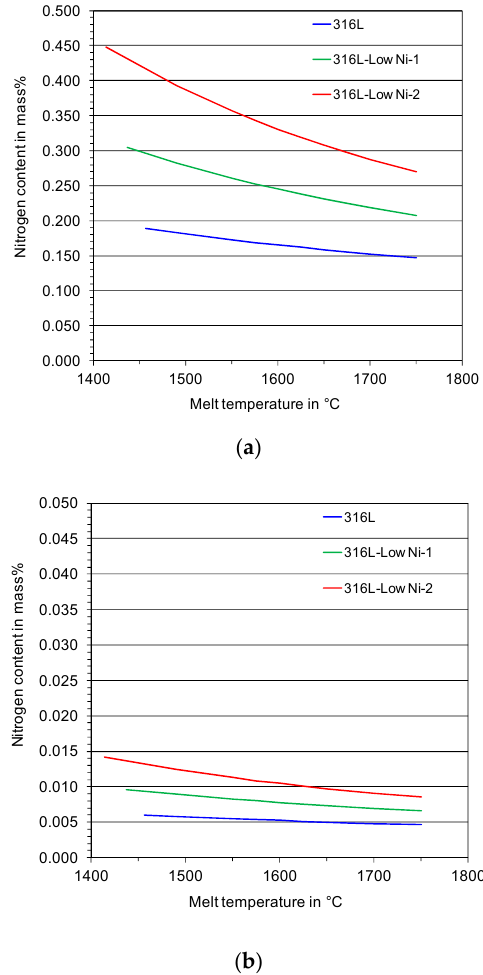
Figure 1. Nitrogen solubility in the austenitic stainless steels at ( a ) 0.1 MPa N 2 and ( b ) 100 Pa N 2 , calculated according to Equations (1) and (2).